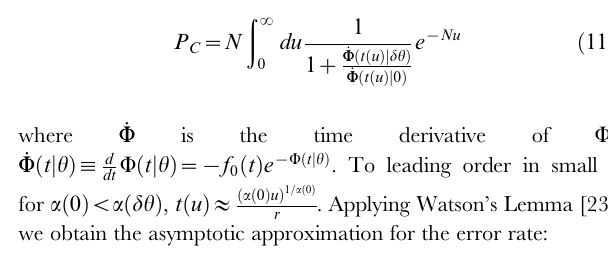
Figure 2. tWTA performance in a 2AFC discrimination task between stimulus 0 u and dh in a two-column model as function of the number of cells in the population. Open symbols show numerical estimation of the tWTA performance as obtained by averaging the probability of correct discrimination over 10 6 realizations of the stochastic neural responses. Probability distribution of first spike times followed an IHPP with the following PSTHs. (a) Scale parameter tuning: r t h { w i jð Þ ~ r h { w i ð Þ H t ð Þ with r 0 ð Þ ~ 50 Hz and dr ~ r dh ð Þ lines show the analytical prediction of equation (9). (b) Shape parameter tuning: r t h { w i jð Þ ~ r H t ð Þ t a h { w i ð Þ with r 0 ð Þ ~ 50 Hz , a 0 ð Þ ~ 1 and ~ 1 : 5,1 : 75,2 from top to bottom. The tWTA performance is shown in terms of P { 1 = g da ~ a dh ð Þ a 0 ð Þ regression lines in keeping with the prediction of equation (12). (c) Delay parameter tuning: r t h { w i jð Þ ~ r H t { t h { w i ð Þð Þ with r 0 ð Þ ~ 50 Hz , t 0 ð Þ ~ 0 and t dh ð Þ ~ 2 ms . The tWTA performance is shown in terms of minus the log of the error rate. The solid line shows the analytical prediction of equation (15).